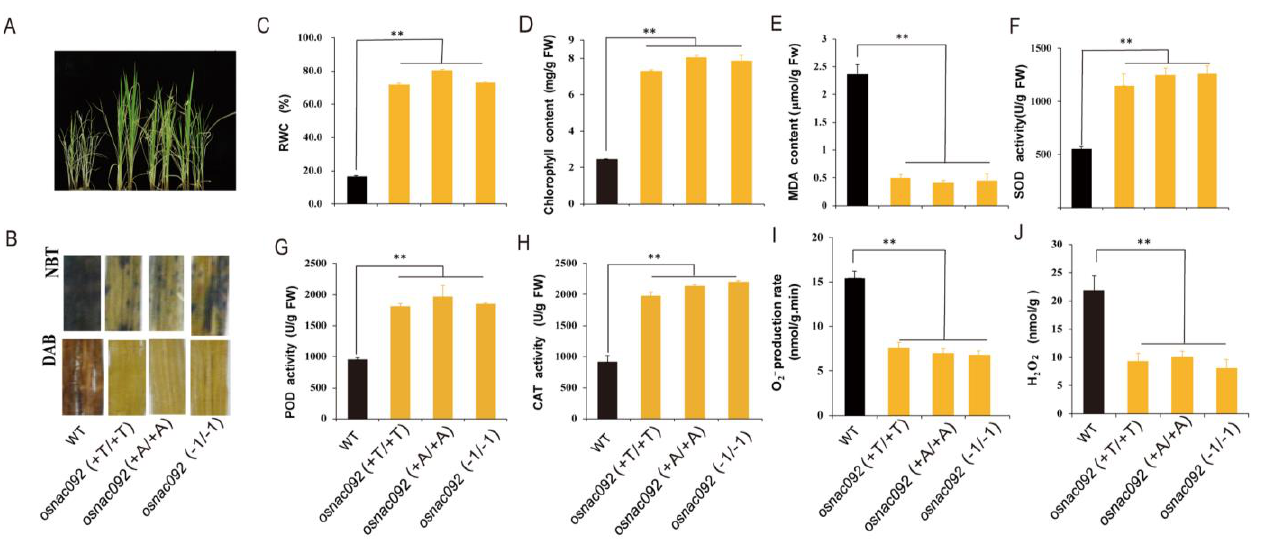
Figure 3. Phenotypic of osnac092 mutants and determination of physiological indexes after drought stress. ( A ). Phenotypic of osnac092 mutants after drought stress. Eight-week-old WT and mutants were selected for 14 days drought stress. ( B ). NBT and DAB staining result. ( C ). relative water content. ( D ). chlorophyll content. ( E ). MDA content. ( F ). SOD activity. ( G ). POD activity. ( H ). CAT activity. ( I ). O2 – content production rate determination. ( J ). H2O2 content determination. The detection of relevant physiological indicators is also 8-week-old + 14 days drought treatment. ** represent significant differences p < 0.01 compared with wide type.